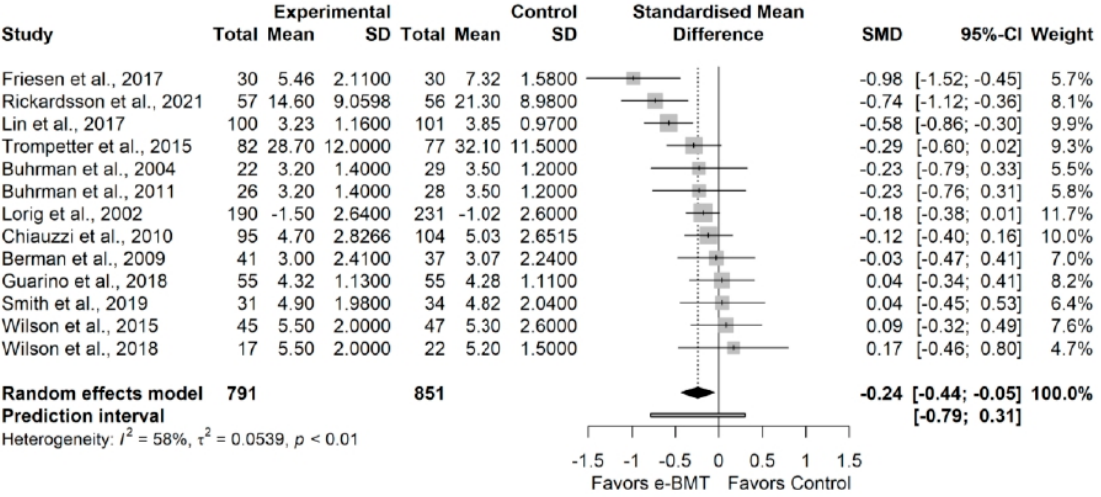
Figure 4. Sensitivity analysis of the kinesiophobia variable for online behavioral techniques against usual care or waiting list. The forest plot summarizes the results of included studies (sample size, mean, standard deviation (SD), standardized mean differences (SMDs), and weight). The small boxes with the squares represent the point estimate of the effect size and sample size. The lines on either side of the box represent a 95% confidence interval (CI).